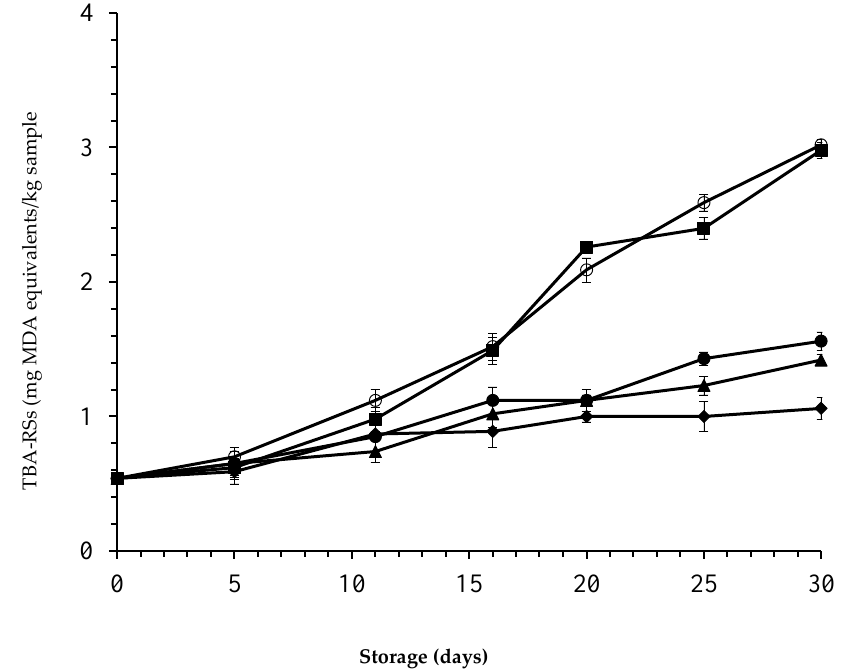
Figure 2. Thiobarbituric acid-reactive substances (TBA-RSs) (mg malonaldehyde/kg meat) in camel steaks stored at 1 ± 1 ◦ C under atmospheres of 80% O 2 and 20% CO 2 after treatment with 25 ppm nisin ( (cid:4) ); 500 ppm laper .OLE ( (cid:78) ); 25 ppm nisin / 500 ppm laper .OLE ( • ); 25 ppm nisin / 1000 ppm laper .OLE ( (cid:117) ); or untreated samples ( ). Error bars represent the standard deviation.